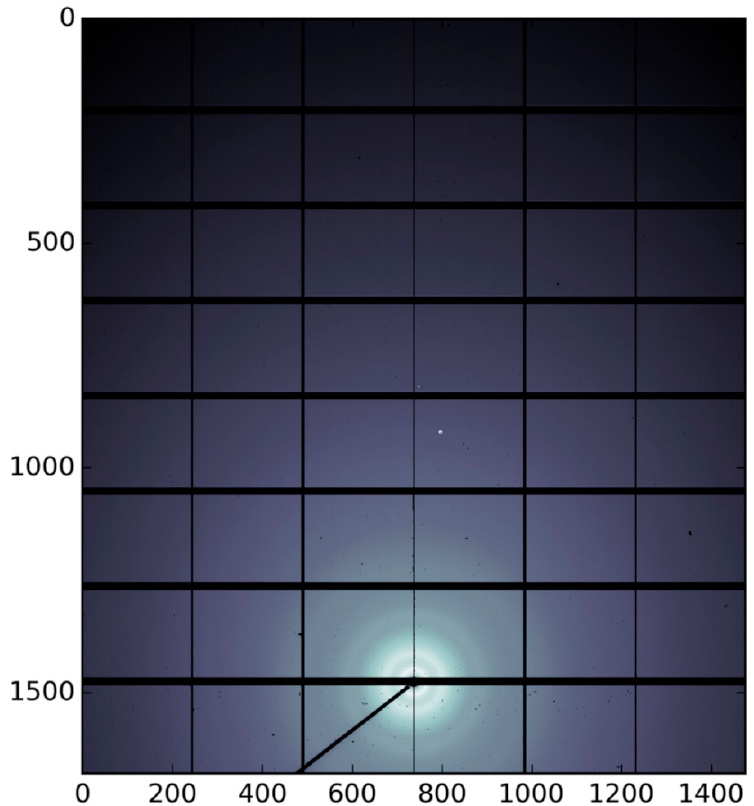
Figure A6. Raw two-dimensional images of PEDOT_SPAES_1.